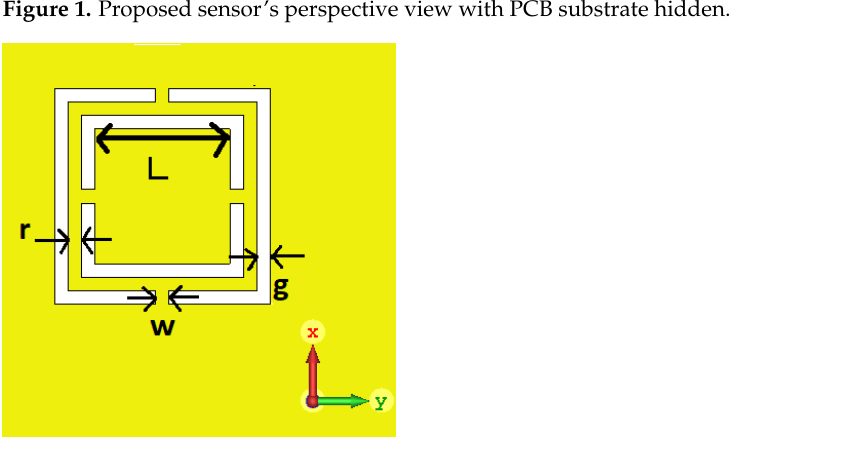
Figure 2. Structure of complementary square ring resonator (resonant structure) (figure